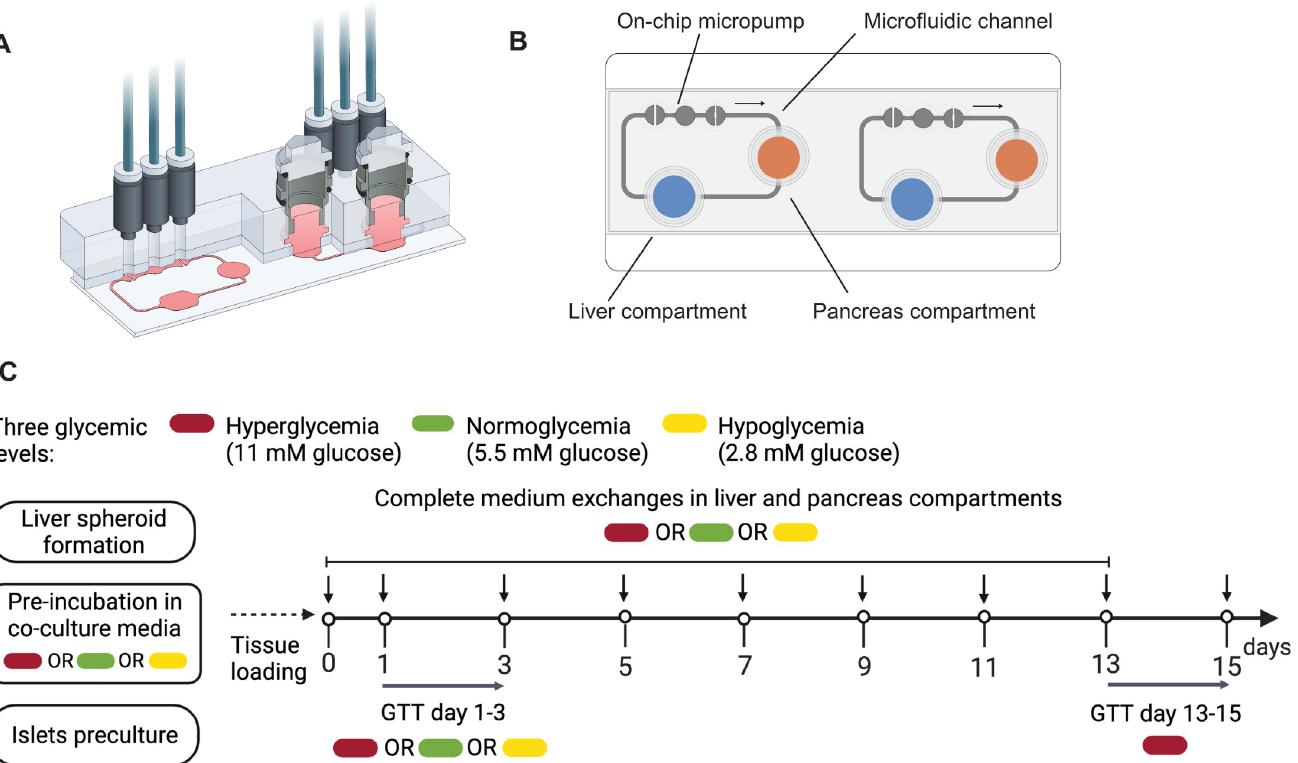
Fig 1. In vitro experiments. (A) A 3D view of the Chip2 (copyright by TissUse GmbH). (B) Illustration of the Chip2 from underneath, including liver (blue) and pancreas (orange) compartments, the microfluidic channel, and the on-chip micropump. The arrow indicates the direction of flow between culture compartments. The Chip2 comprises two replicate platforms. (C) Generic study design used in the experiments performed in the study. In five independent MPS experiments (N = 5), co-cultures or single organ-cultures were exposed to either hyperglycemia (11 mM glucose, N = 5, red), normoglycemia (5.5 mM glucose, N = 3, green) or hypoglycemia (2.8 mM glucose, N = 1, yellow). Medium exchanges occurred every 48 h (vertical black arrows) and glucose tolerance tests (GTTs) were performed on indicated days (horizontal gray arrows). GTT d13-15 was initiated by adding co-culture medium with 11 mM glucose into each of the culture compartments. In GTT d1-3, the glucose concentration in the co-culture medium was set to the glycemic level corresponding to each regime (11 mM, 5.5 mM and 2.8 mM for co- cultures exposed to hyperglycemia, normoglycemia and hypoglycemia, respectively). Samples of the medium were taken 0, 8, 24 and 48 h after the start of the GTT. Figure created with